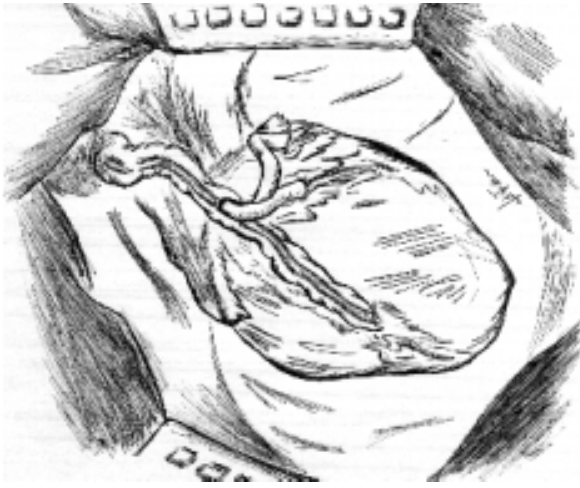
circunflexa.Fig. 1 - Enxerto composto, formado pela ATIE anastomosada na artéria DA; segmento de VSM originando-se da ATIE para diagonal; e um segundo segmento de VSM oriundo do primeiro para um ramo marginal da artéria